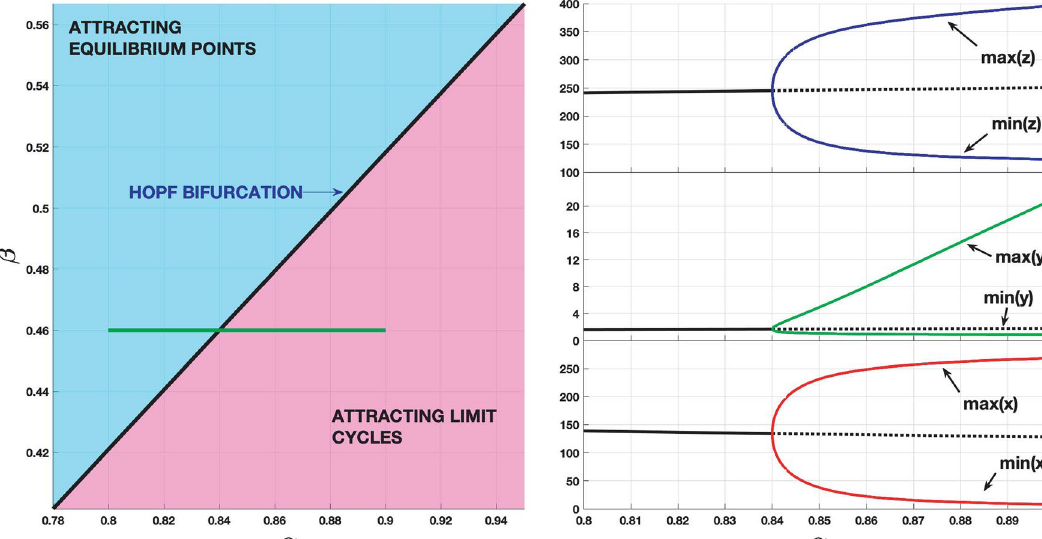
Figure 6. Bifurcation diagram of the Glaciator . Left panel: the Hopf bifurcation is supercritical and the oscillations arise for parameter values to the bottom-right side of the bifurcation curve. Right panel: the onset of the cycle as α increases along the green segment ( β = 0.46) depicted in the left panel ( z = blue, y = green, x =